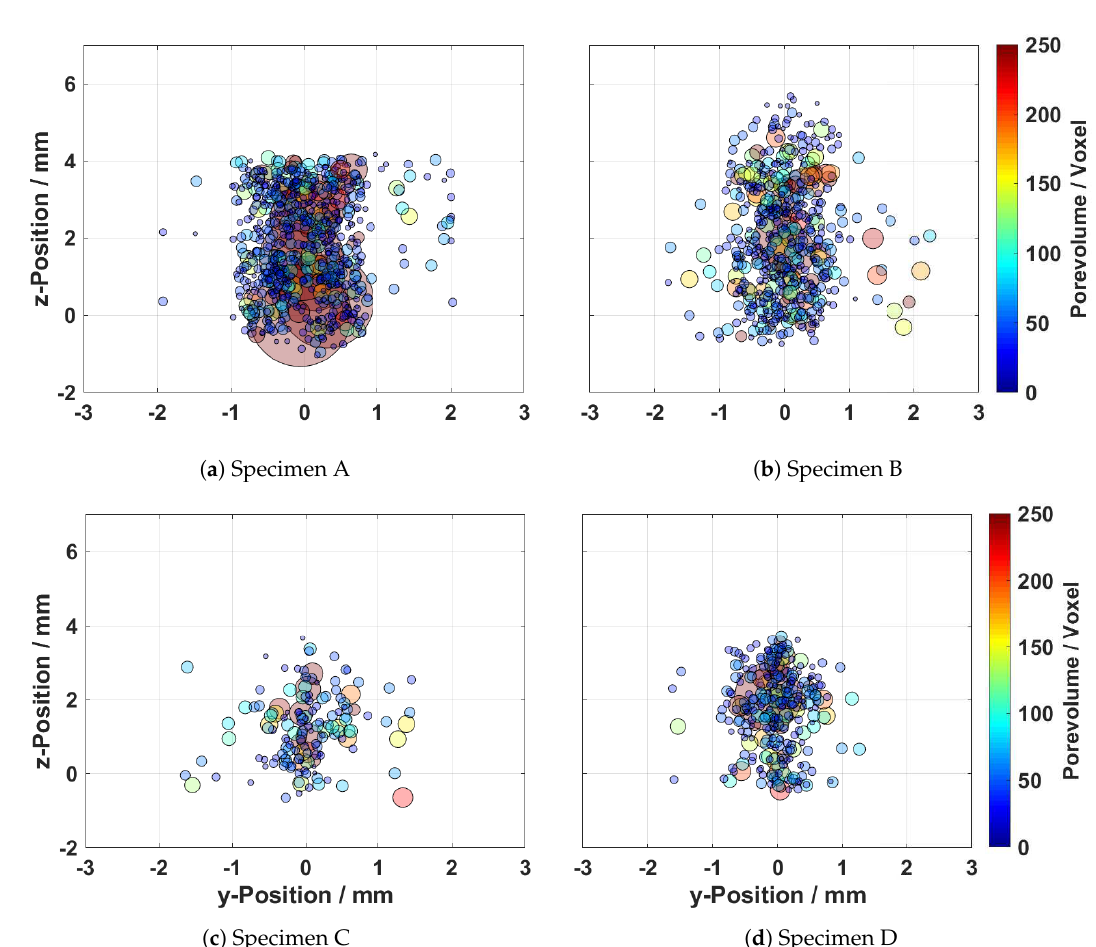
Figure 6. Cross sectional zy-projection of the position of the pores. The sizes of the pores are depicted in